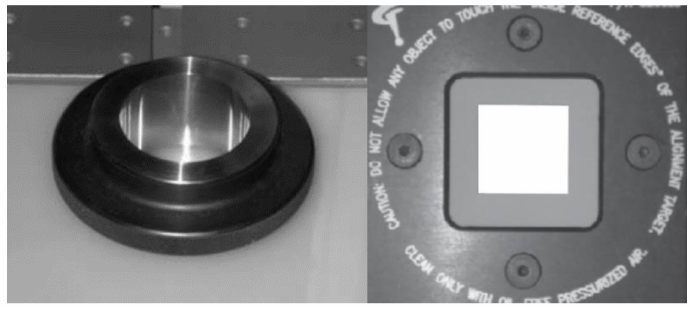
Figure 5. Ring gauge and rectangle.